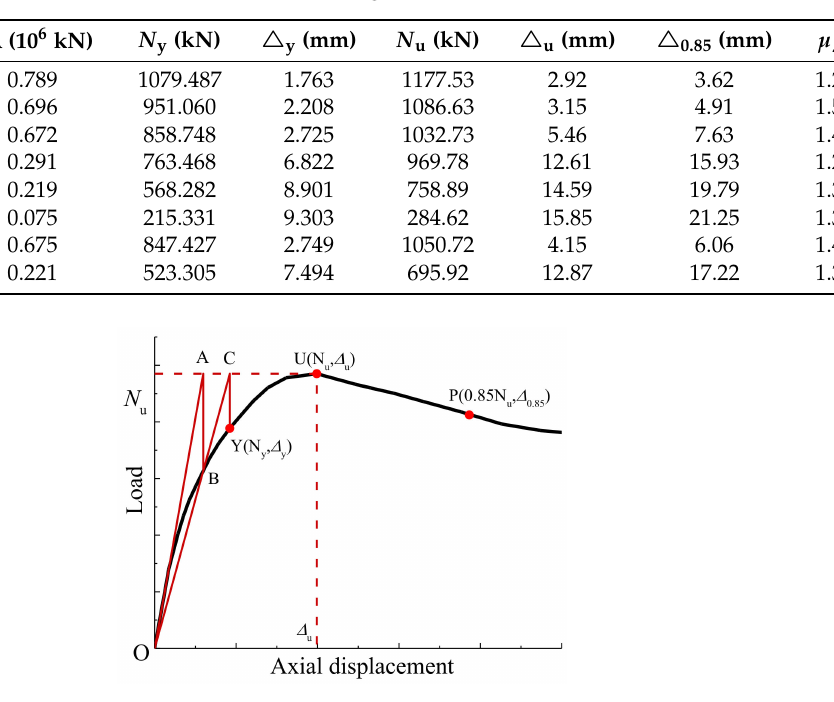
Figure 7. The geometric drawing